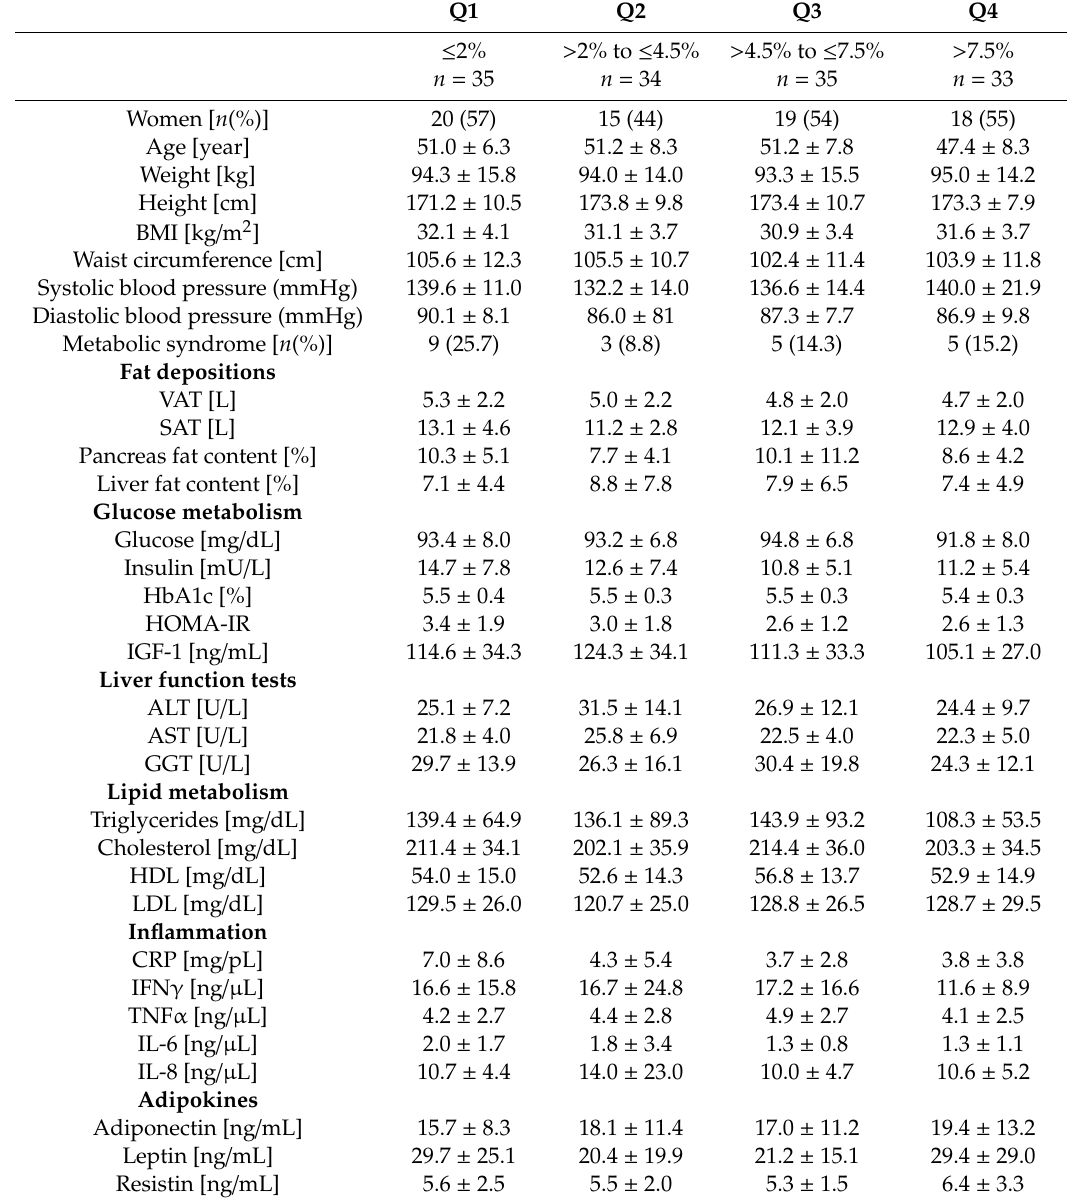
Table 1. Characteristics of the four weight-loss groups (Q1 to Q4) at baseline (T0), n =